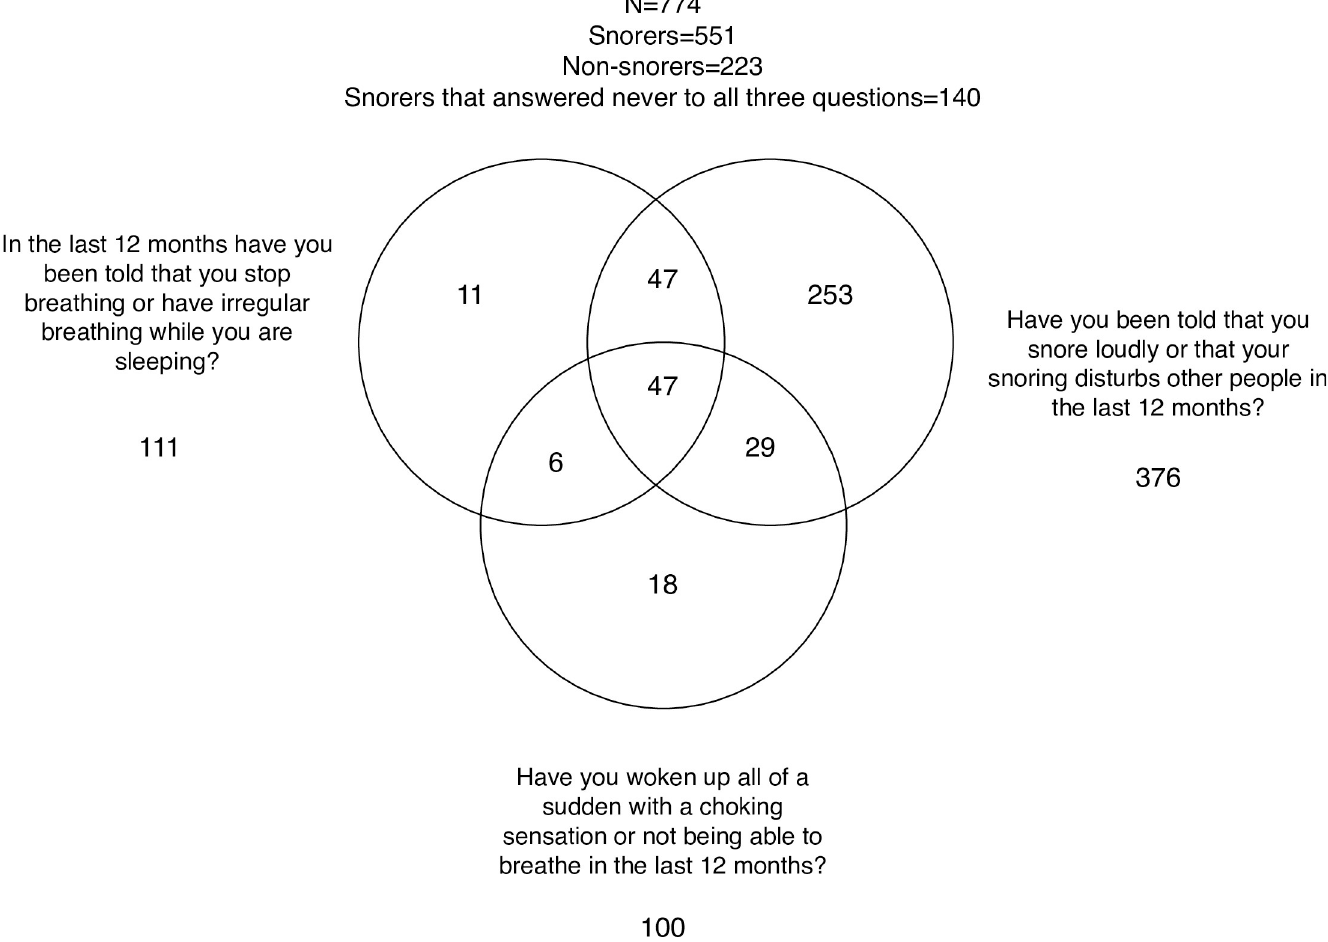
Fig 2. Venn diagram outlining the inter-presence of sleep apnea